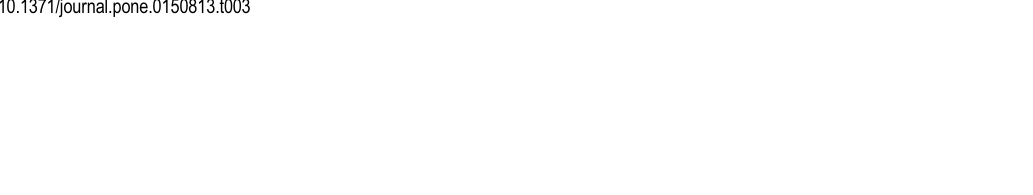
Average Percent of criteria sets in which elevated turbine risk was due